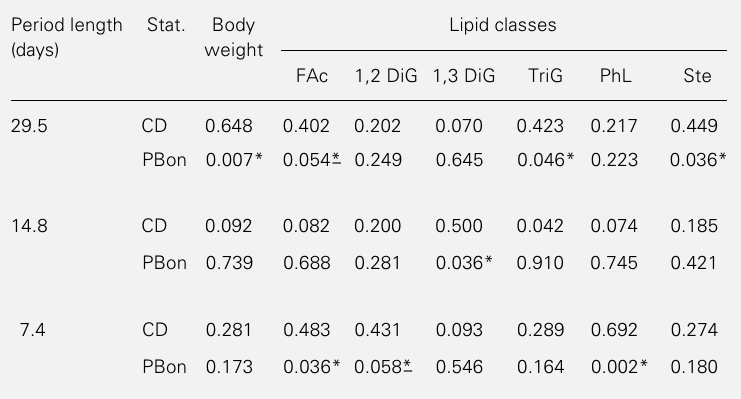
Table 1 - Statistical parameters (stat.) of moon phase dependence of body weight and hemolymph concentrations of various lipid classes in worker honeybees. CD = Coefficient of determination, i.e., the fraction of the total variance of the data explained by the regression equation; PBon = P value by Bonferroni modification. Period length indicates lunar (29.5 days), semi-lunar (14.8 days), and quarter-lunar (7.4 days) periodicities. FAc = Fatty acids; 1,2DiG = 1,2 diacylglycerols; 1,3DiG = 1,3 diacylglycerols; TriG = triacylglycerols; PhL = phospholipids; Ste = steroids. Asterisks (*) indicate the P £ 0.05 level of significance. Underlined asterisks (*-) denote limit cases with